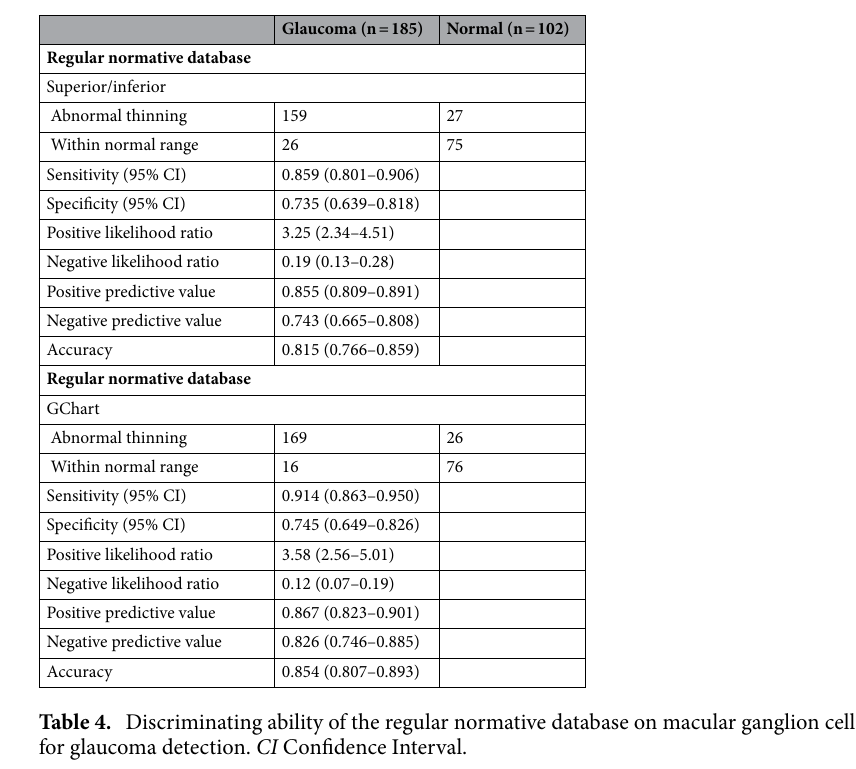
Glaucoma (n = 185) Normal (n =